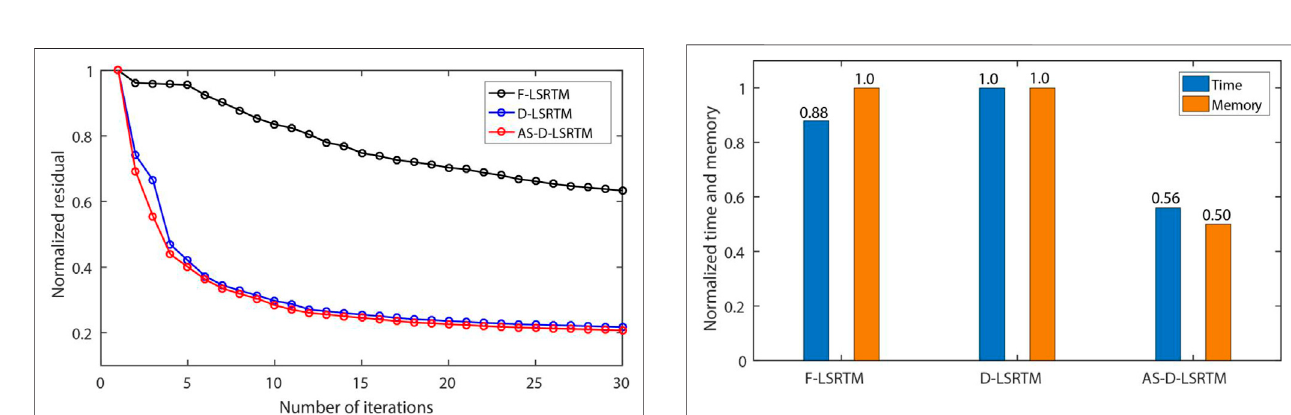
FIGURE 10 | Computing time and memory requirement of the three